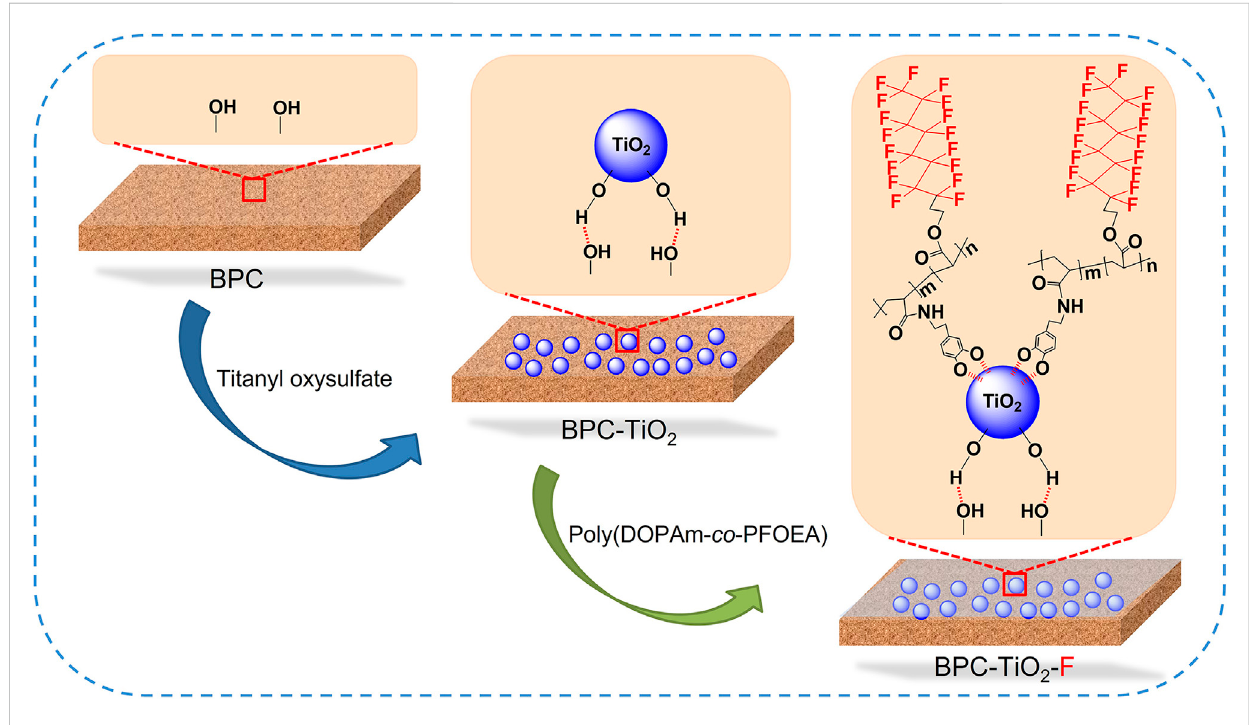
FIGURE 1 Schematic of surface modi fi cation of BPC by TiO 2 particles and poly(DOPAm- co